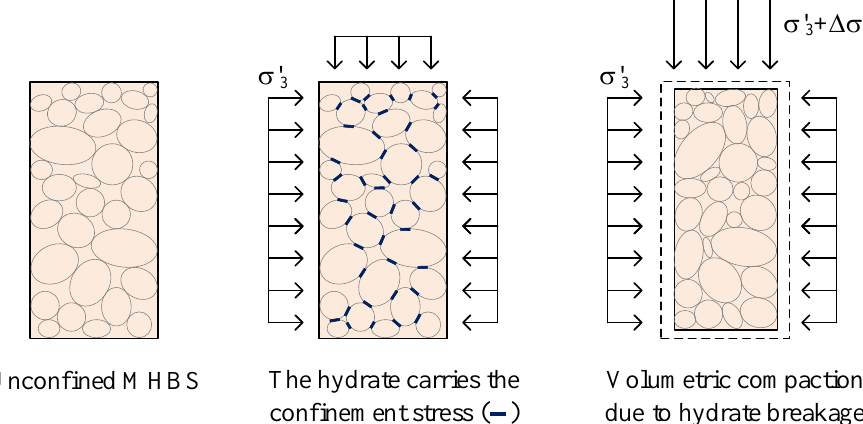
Figure 9. Illustration of volumetric contraction due to hydrate breakage as deviatoric stress is